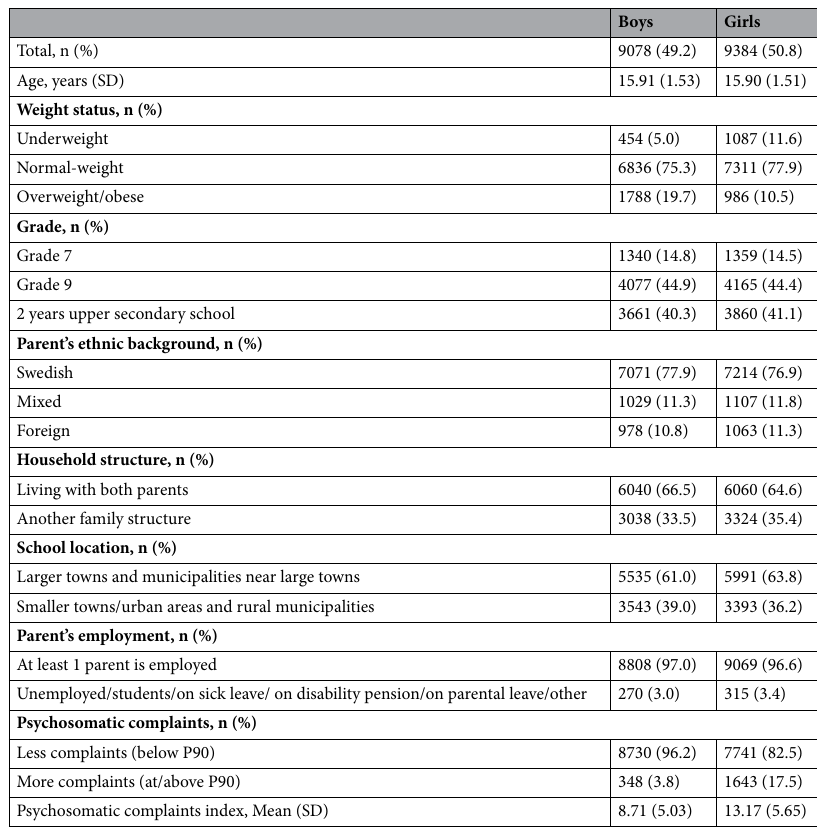
Table 1. Socio-demographic characteristics of students included in the analyses. SD standard deviation; P90 90th percentile.